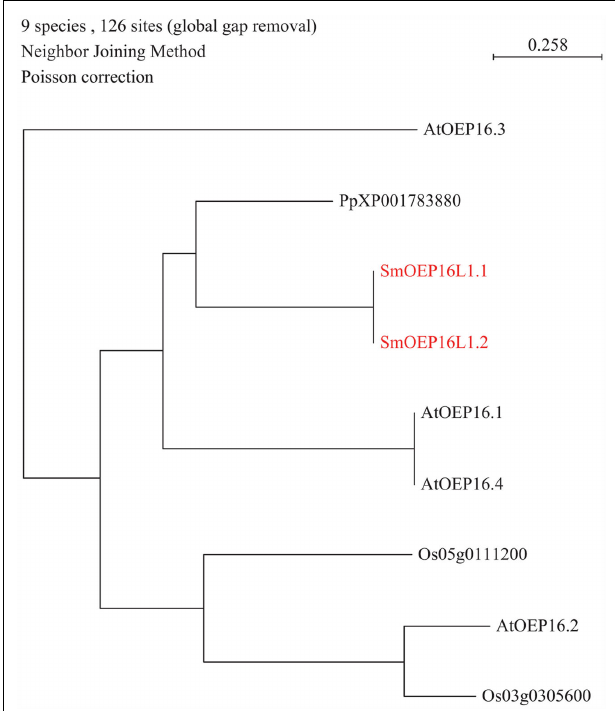
FIGURE 4 | Phylogenetic tree of outer envelope plastid (OEP) transporter family. The alignment was obtained from ClustalW and tree was build using PAUP software. At, Arabidopsis thaliana ; Os, Oryza sativa ; Pp, Physcomitrella patens ; Sm, Selaginella moellendorffii. Red letters indicate a Selaginella moellendorffii